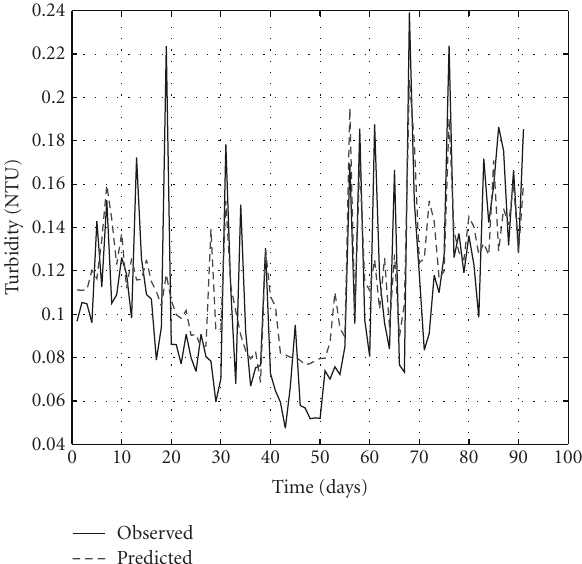
Figure 4: Observed turbidity and the values predicted by the MLP model when using the 8 best variables.